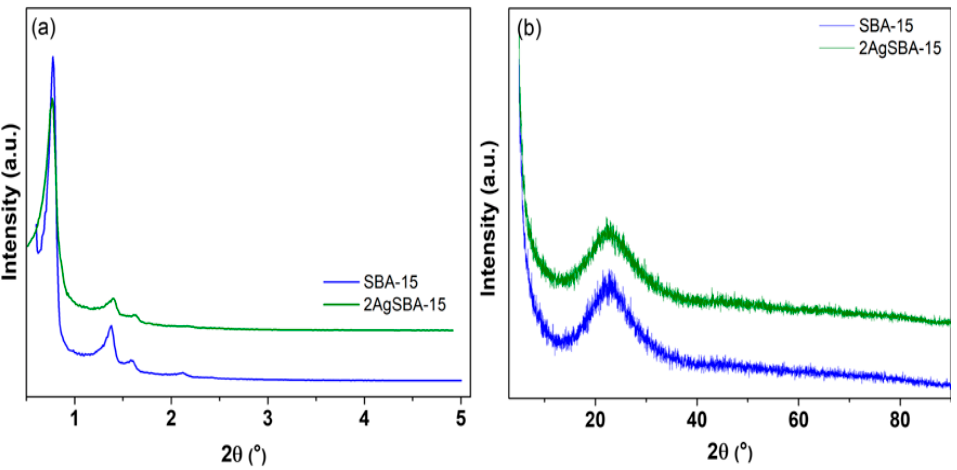
Figure 1. ( a ) Low-angle and ( b ) wide-angle X-ray diffractograms for SBA-15 and 2AgSBA-15 adsorbents.